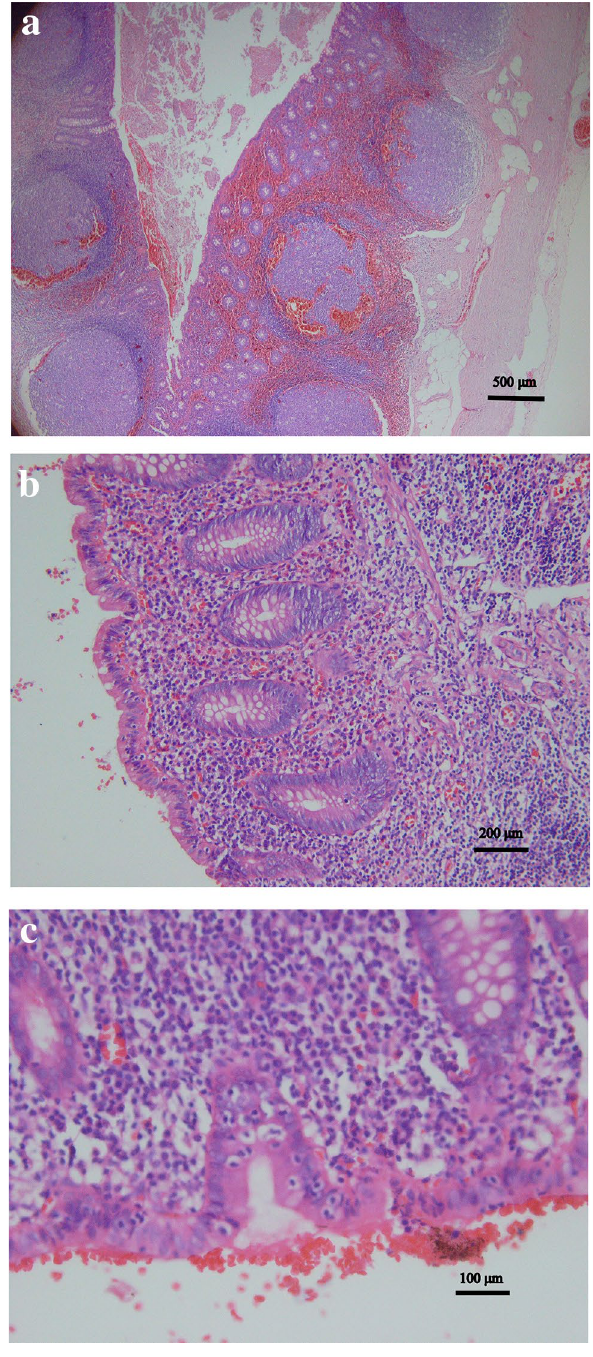
Figure 1. Pathological features of acute appendicitis in Tibetan students, as shown by hematoxylin and eosin stain. ( a ) diffuse hemorrhages in the lamina propria and lymphoid follicles as well as in the lumen of the appendix . ( b ) Infiltration of the lamina propria by scattered eosinophils. ( c ) The epithelium is infiltrated by